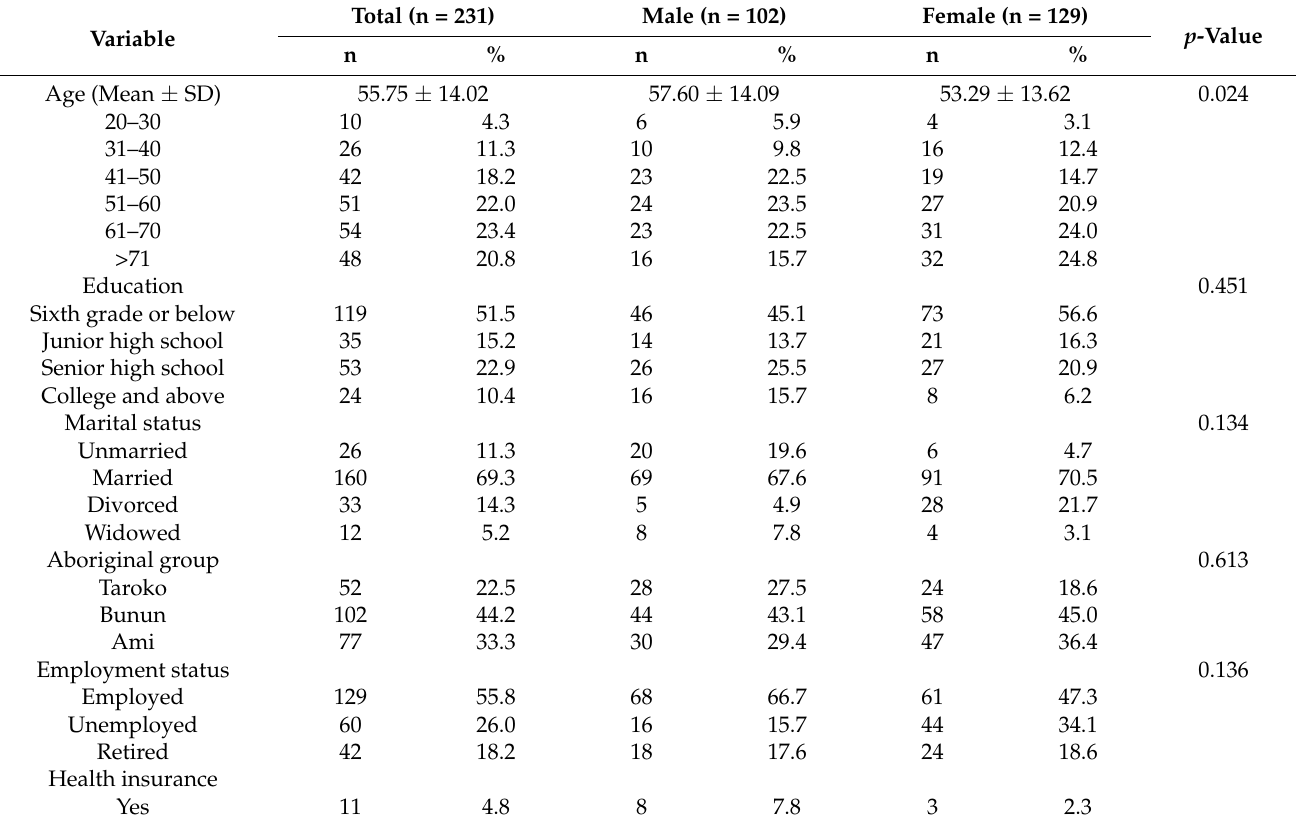
Table 1. Participant sociodemographic characteristics (n =